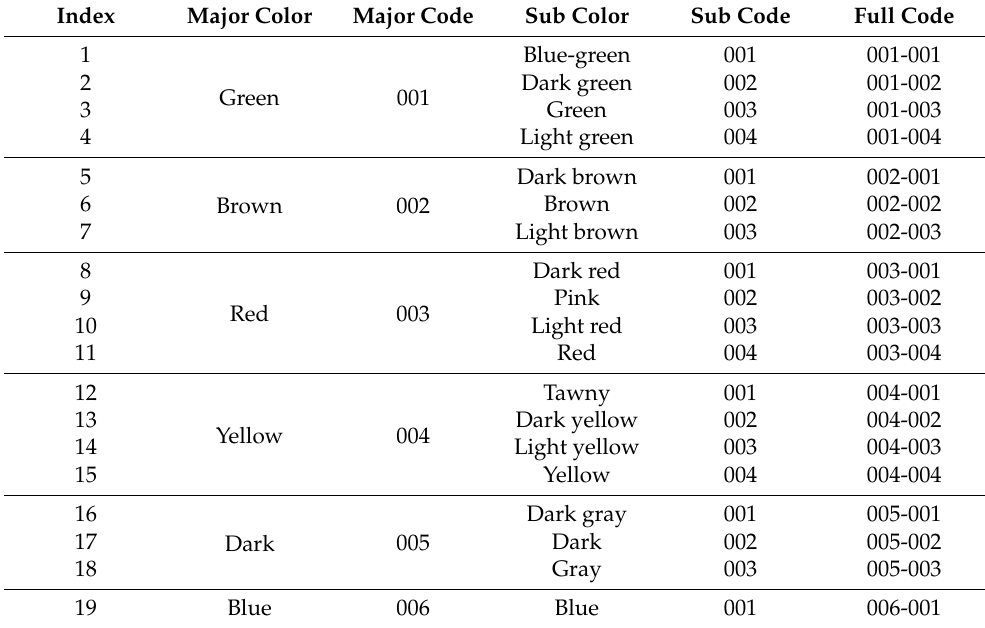
Table 4. Coding status of 19 water color categories.